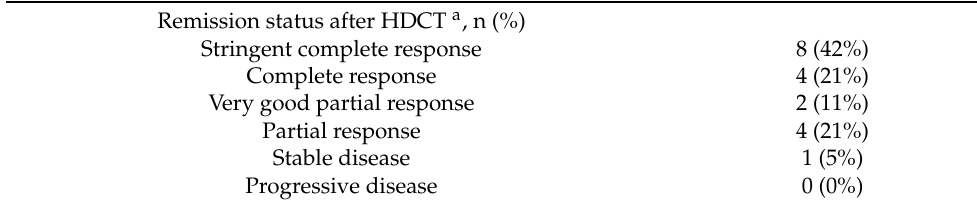
Table 5. Follow-up data after HDCT and ASCT in the study